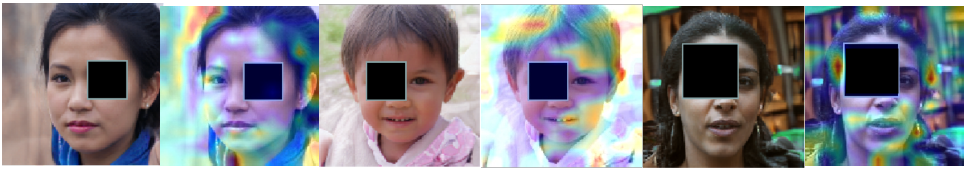
Figure 14. Face images detected as fake (attention change). In this figure, the fake face is from the open-source StyleGAN